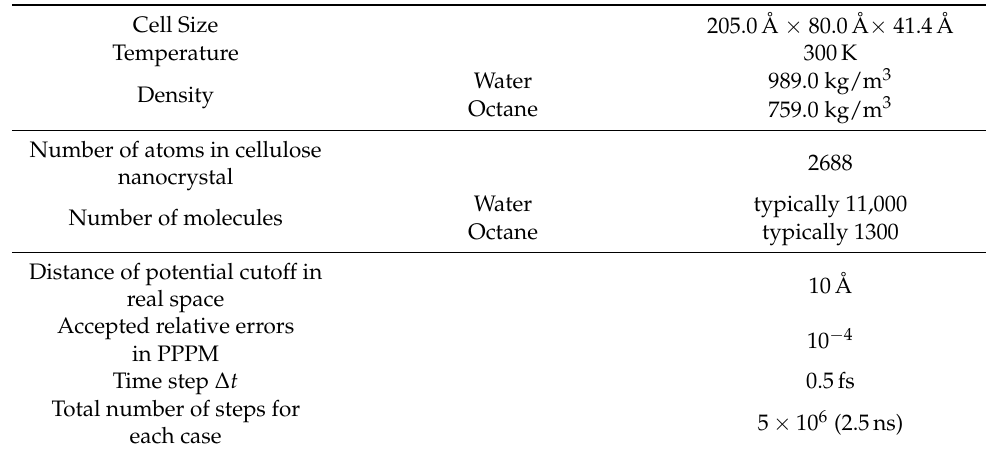
Table 1. Simulation conditions. The exact number of solvent molecules (water and octane) varies in cases since overlapping molecules are removed when the cellulose nanocrystal is inserted in the